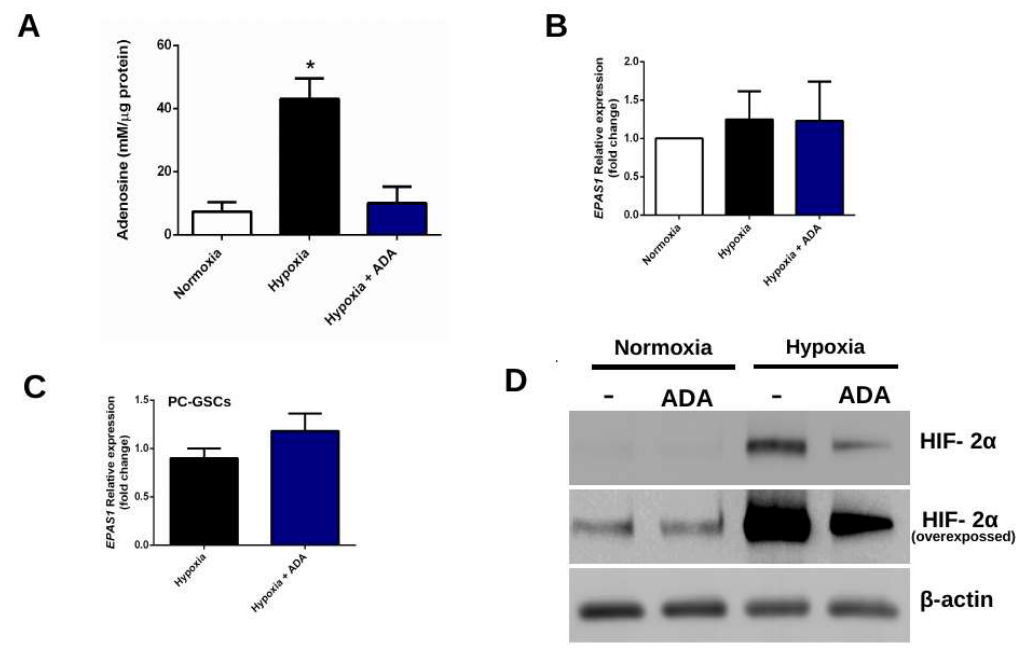
Figure 1. HIF-2 α levels under hypoxia and adenosine depletion. ( A ) Extracellular adenosine Figure 1. HIF-2α levels under hypoxia and adenosine depletion. ( A ) Extracellular adenosine quantification of U87-GSCs under hypoxia treated with 1 U / mL ADA for 24 h. Adenosine concentration quantification of U87-GSCs under hypoxia treated with 1 U/mL ADA for 24 h. Adenosine (nM) was normalized to total protein levels ( µ g) ( B ) EPAS1 (HIF-2 α ) transcript levels of U87-GSCs concentration (nM) was normalized to total protein levels (μg) ( B ) EPAS1 (HIF-2α) transcript levels under hypoxia and 1 U / mL ADA for 24 h were measured by RT-qPCR ( C ) Same as in B, but with of U87-GSCs under hypoxia and 1 U/mL ADA for 24 h were measured by RT-qPCR ( C ) Same as in B, PC-GSCs ( D ) HIF-2 α protein levels of U87-GSCs under normoxia or hypoxia treated with 1 U / mL ADA but with PC-GSCs ( D ) HIF-2α protein levels of U87-GSCs under normoxia or hypoxia treated with 1 for 24 h were analyzed by western blot. n = 3, * p < U/mL ADA for 24 h were analyzed by western blot. n = 3, * p < 0.05.